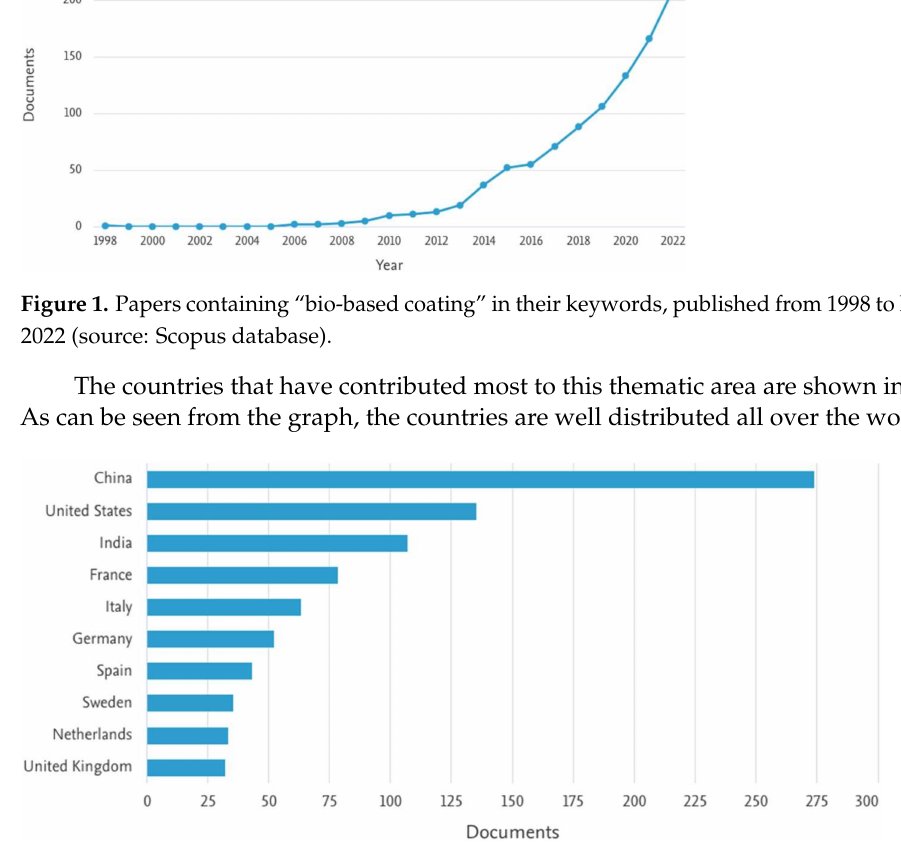
Figure 2. Top 10 countries by number of publications relating to “bio-based coating” (source: Scopus